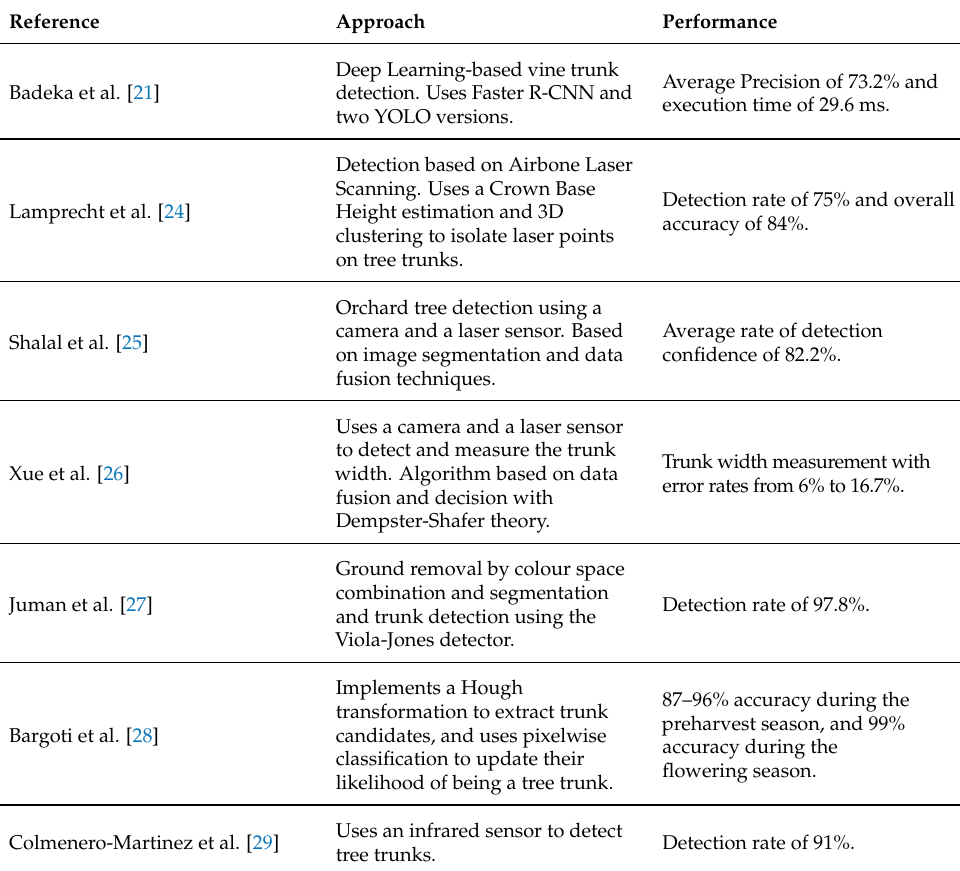
Table 1. Summary of the current state-of-the-art regarding tree trunk detection in agricultural